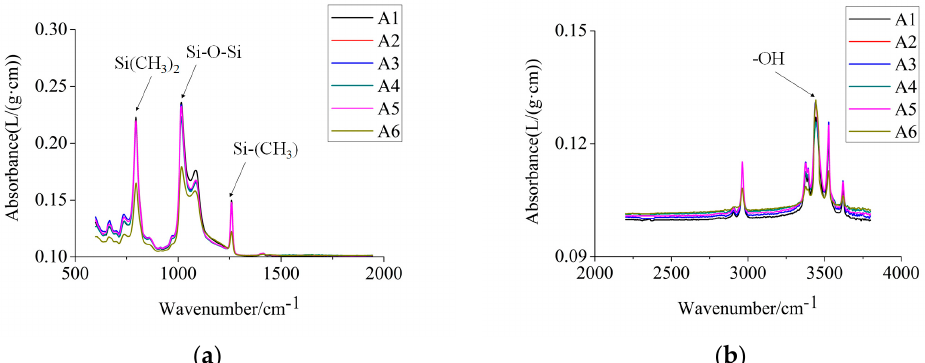
Figure 4. FTIR analysis results of samples under different years: ( a ) wave number between 500 and 2000 cm − 1 ; ( b ) wave number between 2000 and 4000 cm − 1 .